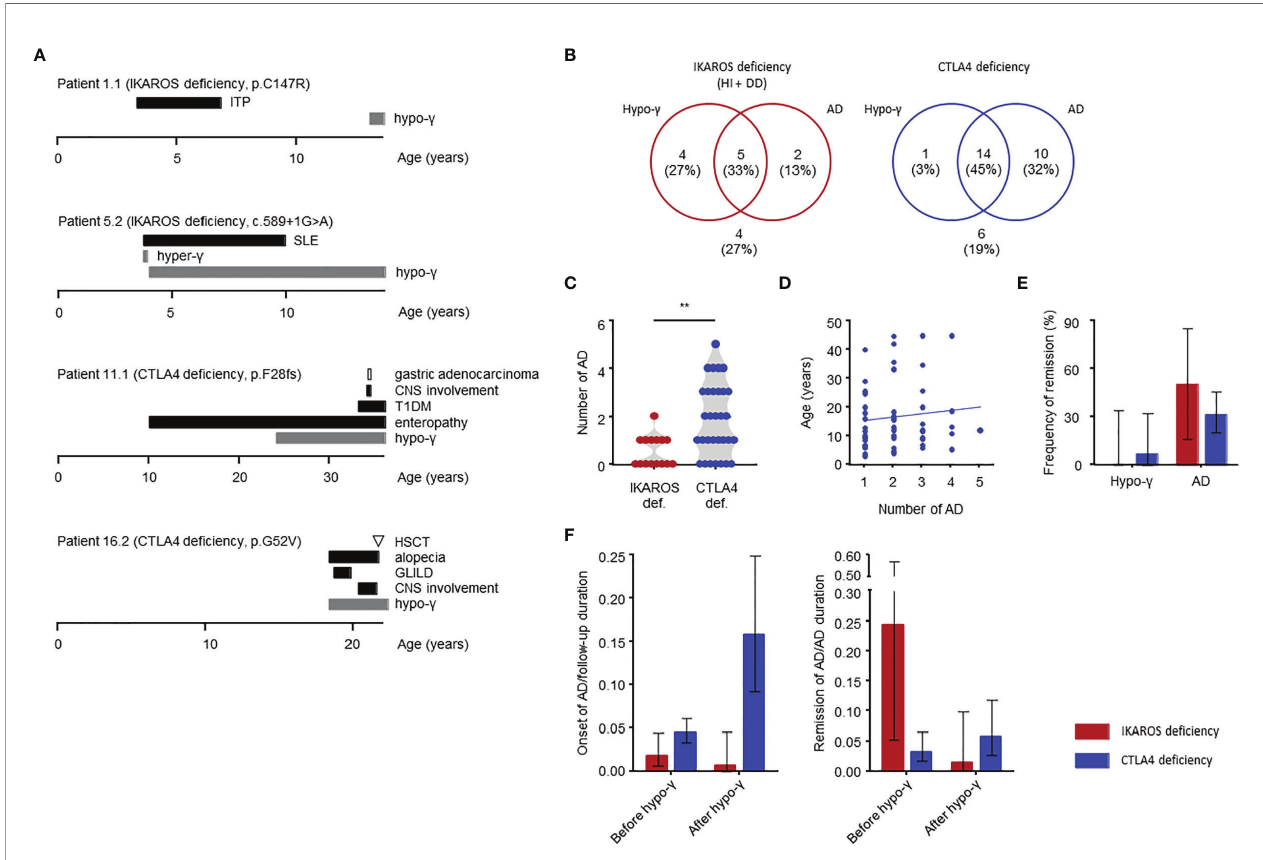
FIGURE 4 | Clinical manifestations in IKAROS and CTLA4 de fi ciencies determined by longitudinal study. (A) Case reports of four patients. The AD duration is de fi ned as from onset to the end of treatment with no symptoms or laboratory abnormalities. CNS, central nervous system; GLILD, granulomatous, and lymphocytic interstitial lung disease; HSCT, hematopoietic stem cell transplantation; hyper- g , hypergammaglobulinemia; SLE, systemic lupus erythematosus; T1DM, type 1 diabetes mellitus. (B) Distribution of complications. (C) Number of autoimmune diseases. (D) Total number of autoimmune disease and age at onset for CTLA4 de fi ciency. (E) Frequency of remission of hypogammaglobulinemia and autoimmune disease. (F) Incidence of autoimmune disease onset or remission before and after onset of hypogammaglobulinemia shown as per 1 person-year. The person-year is the sum of the patient follow-up deration (years) for the onset, and the sum of the patient autoimmune disease duration (years) for the remission. The groups were compared using a Mann-Whitney U -test in (C) . ** P < 0.01. Thin bars are presented as 95% CIs in (E, F) . AD, autoimmune disease; hypo- g , hypogammaglobulinemia.